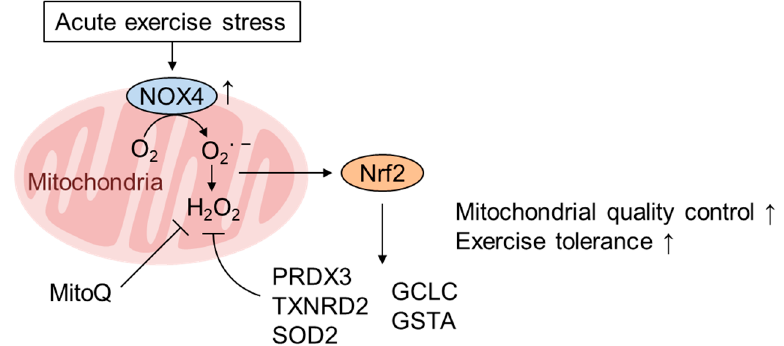
Figure 3. Acute exercise activates Nrf2 via NOX4 expression in the heart. Acute exercise stress